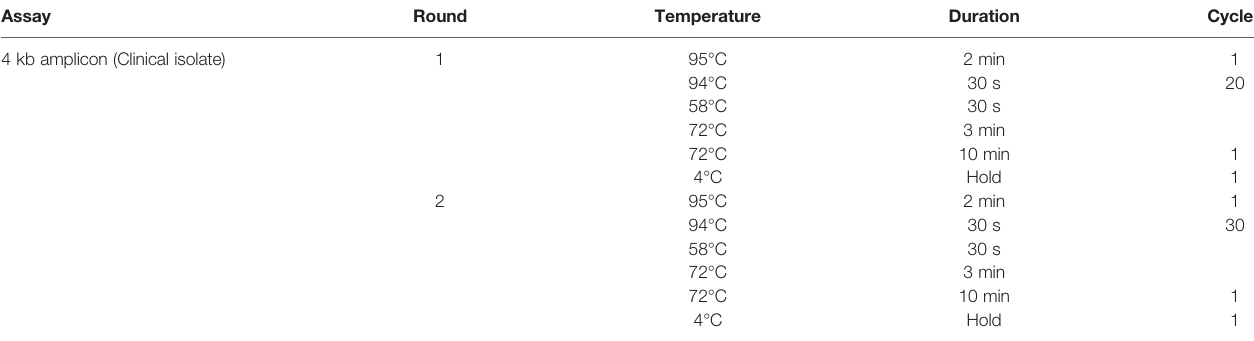
TABLE 1 | PCR thermal cycler conditions for amplifying the 4 kb fragment from the Cohort sample.